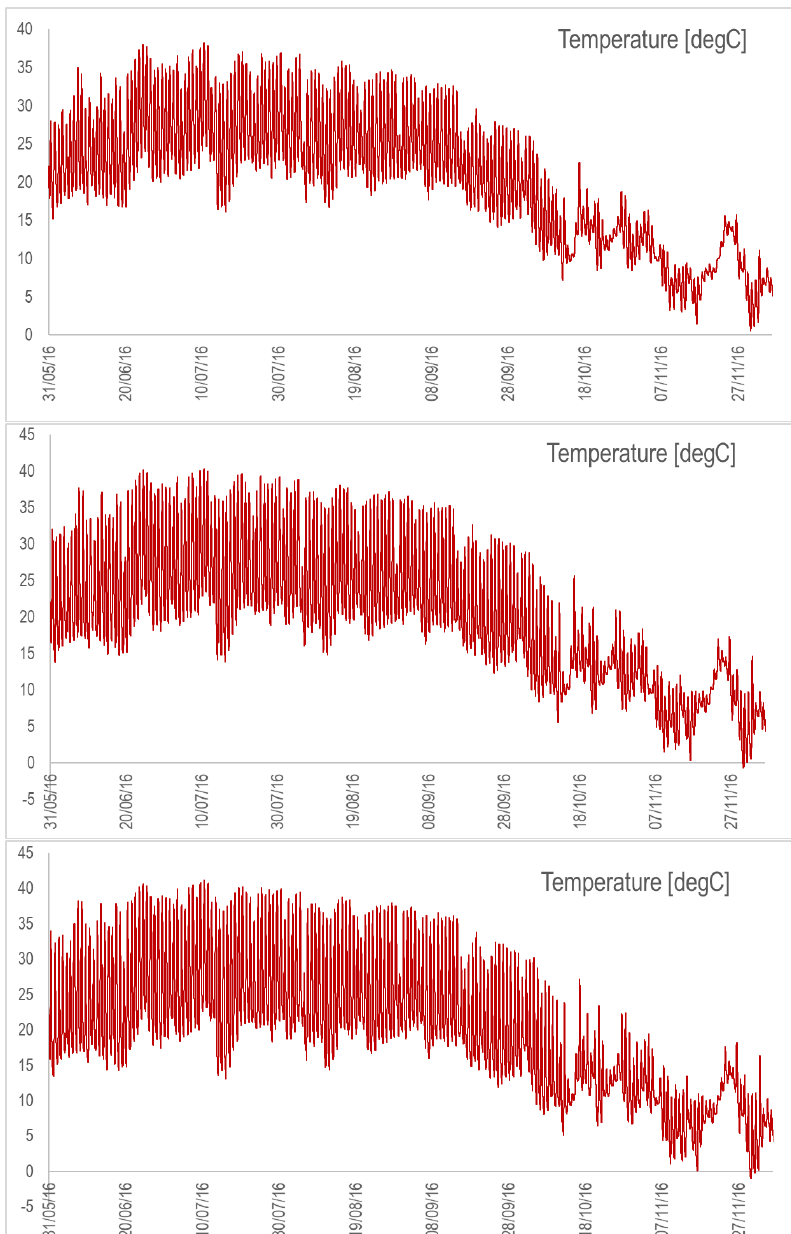
Figure A4. Temperature dynamics for the suspended raceway with the nominal depth ( top ), depth di- vided by 2 ( middle ), and depth divided by 3 ( bottom ). Simulations are from May to November